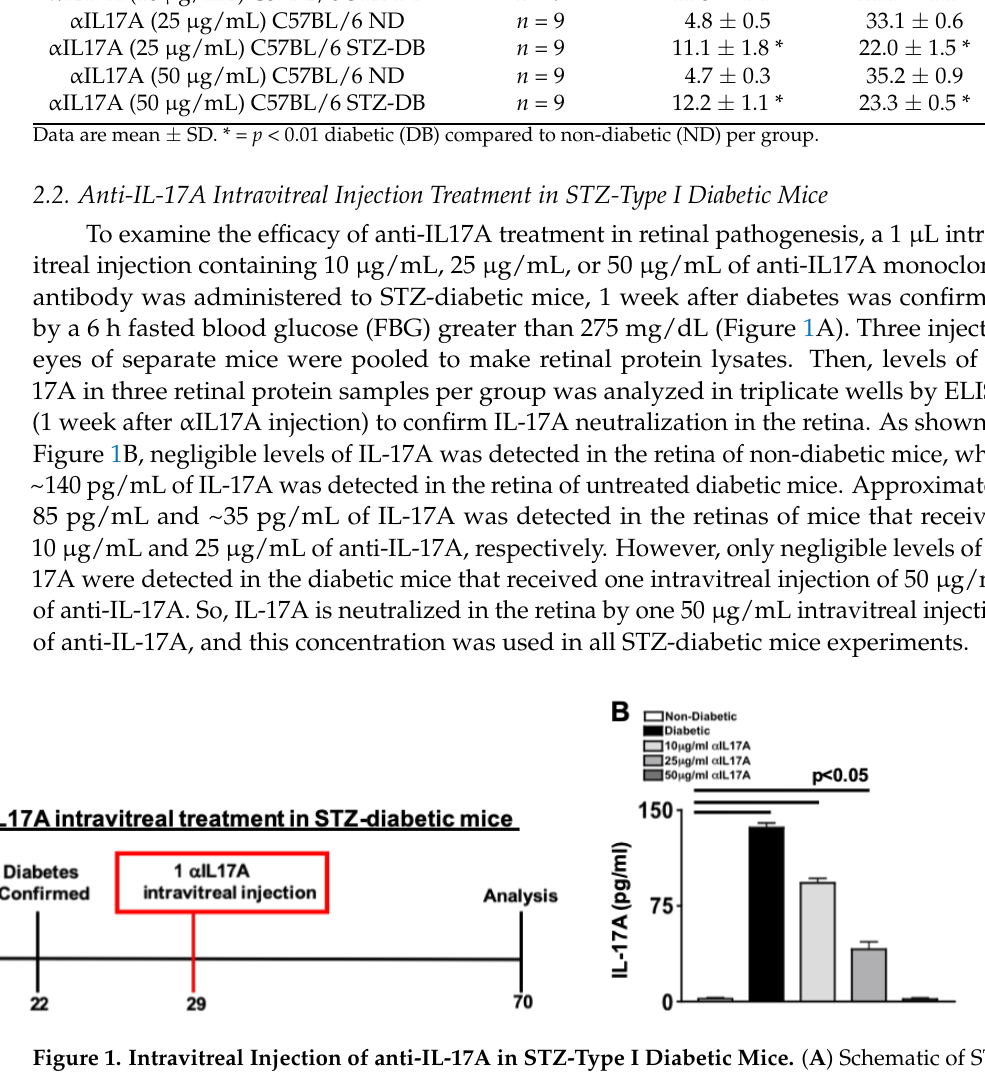
Figure 1. Intravitreal Injection of anti-IL-17A in STZ-Type I Diabetic Mice. ( A ) Schematic of STZ- Type I diabetic retinopathy murine model and anti-IL-17A intravitreal injection. ( B ) Quantification of IL-17A in retinas of non-diabetic, untreated diabetic, and 10 µ g/mL, 25 µ g/mL, and 50 µ g/mL of anti-IL-17A treated diabetic mice; 1 week after one intravitreal injection. Error bars represent the SEM. The p-value was first equated by 2-way ANOVA analysis and then unpaired student’s t -test with Tukey’s post-hoc